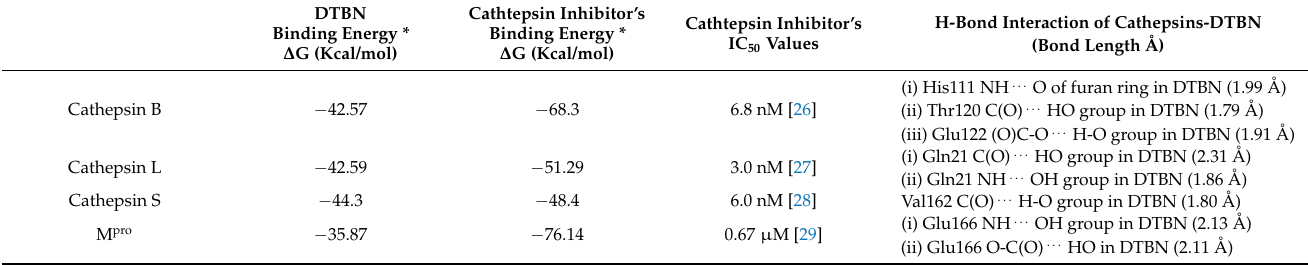
Table 1. DTBN binding energy * ( ∆ G) with Cathepsins and M pro